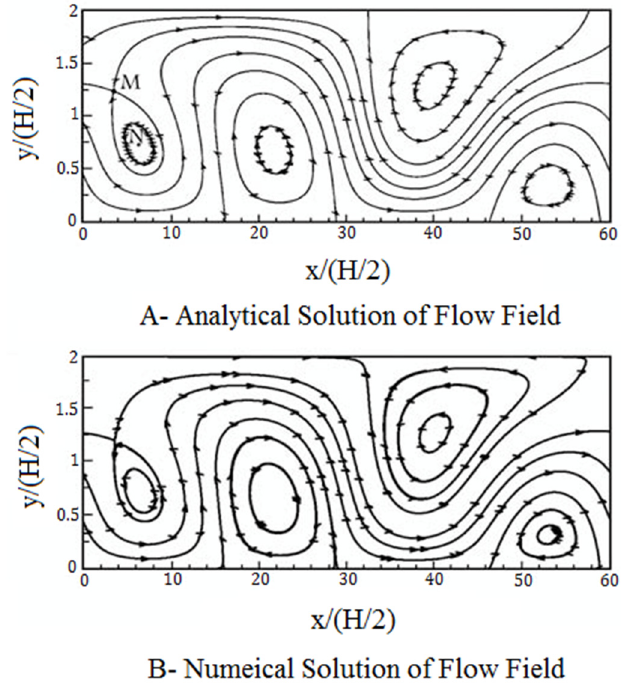
Figure 2. Streamlines obtained by ( A ). analytical solution and ( B ). numerical solution through the H–S approximate model.